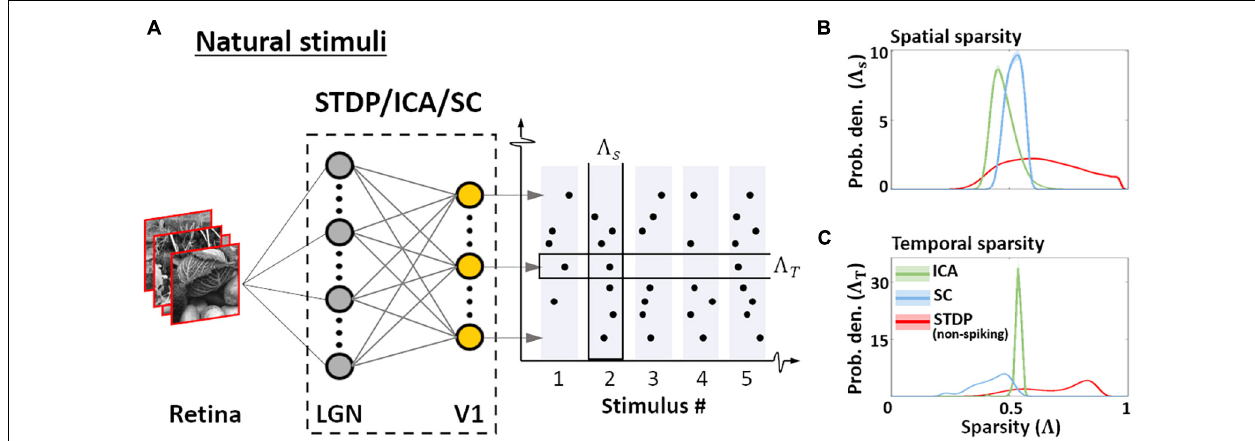
FIGURE 5 | Sparsity. (A) Sparsity indices. To estimate the sparsity of the non-spiking responses to natural stimuli, 10 4 patches (3 ◦ × 3 ◦ visual angle) randomly sampled from natural scenes were presented to the three models. Two measures of sparsity were defined: Spatial sparsity Index ( (cid:51) S ) was defined as the average sparsity of the activity of the entire neuronal ensemble, while Temporal sparsity Index ( (cid:51) T ) was defined as the average sparsity of the activity of single neurones to the entire input sequence. (B) Spatial sparsity. Estimated probability density of (cid:51) S for ICA (green), Sparse Coding (blue), and STDP (red). (cid:51) S varied between 0 (all units activate with equal intensity) and 1 (only 1 u/U activates) by definition. (C) Temporal sparsity. Estimated probability density of (cid:51) T , shown in a manner analogous to (cid:51) S (panel B ). (cid:51) T also varied between 0 (homogeneous activity for the entire input sequence) and 1 (activity only for few inputs in the sequence).